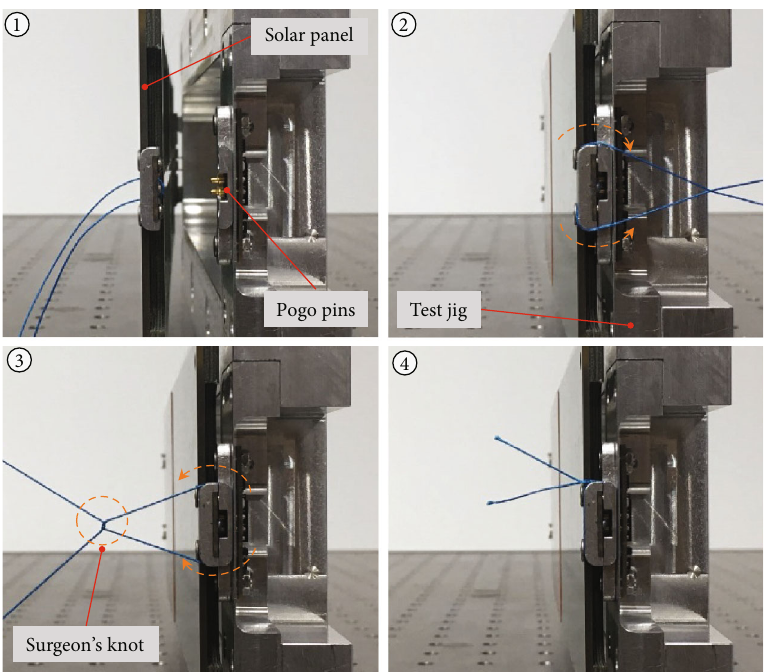
Figure 4: Nylon wire tightening process for holding constraint at the panel.